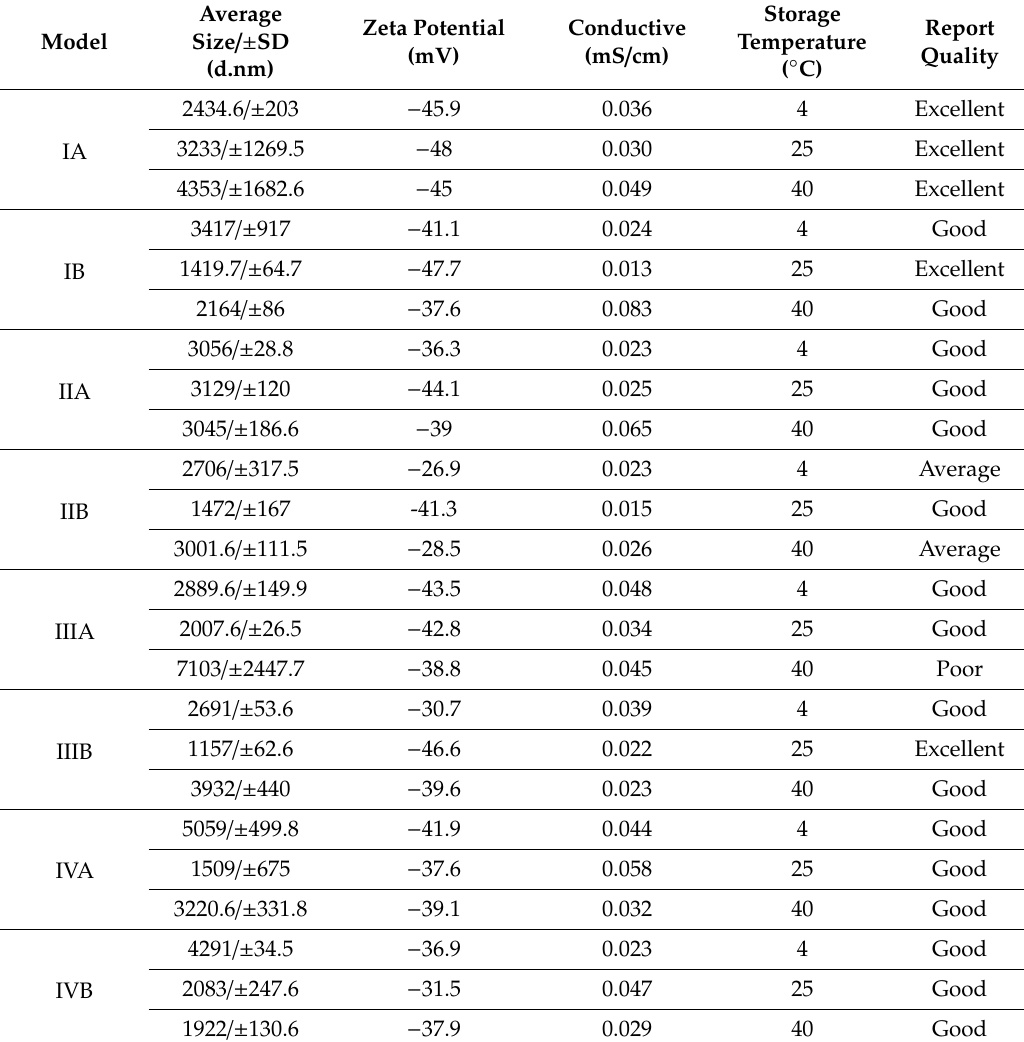
Table 4. Globule size and zeta values of model IA to IVA and their controls at 4 ◦ C, 25 ◦ C and 40 ◦ C after 14